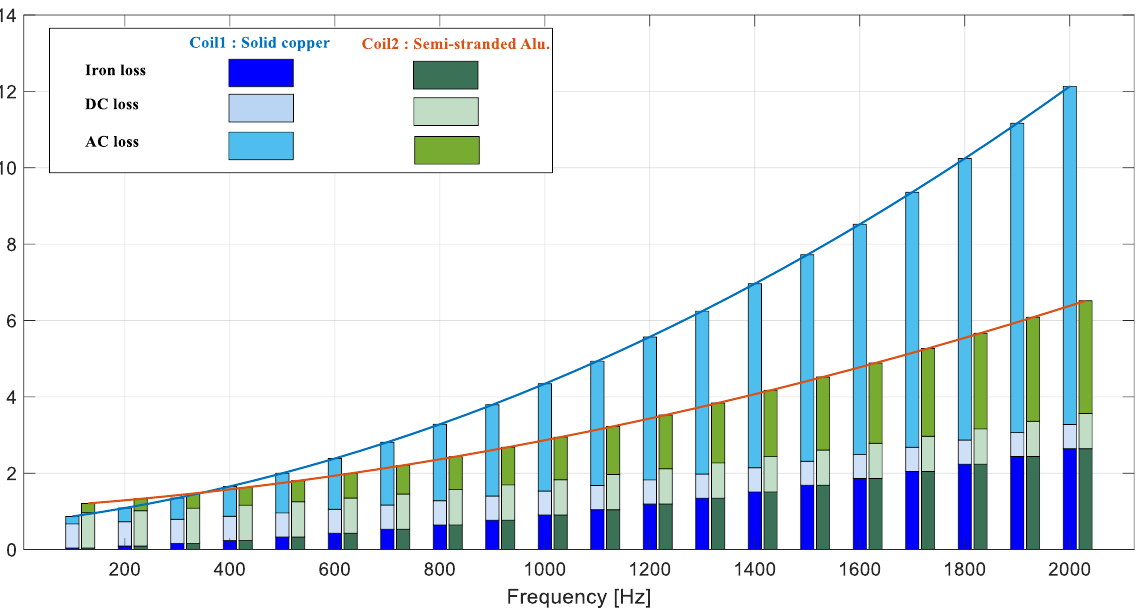
The results are compared with those from the AM solid copper coil, as shown in Figure 13. As expected, the total AC losses of the semi stranded aluminum coil start to reduce significantly at frequencies above 300 Hz. Additionally, the total power losses are decomposed into three main components; core losses, DC losses, and AC losses.